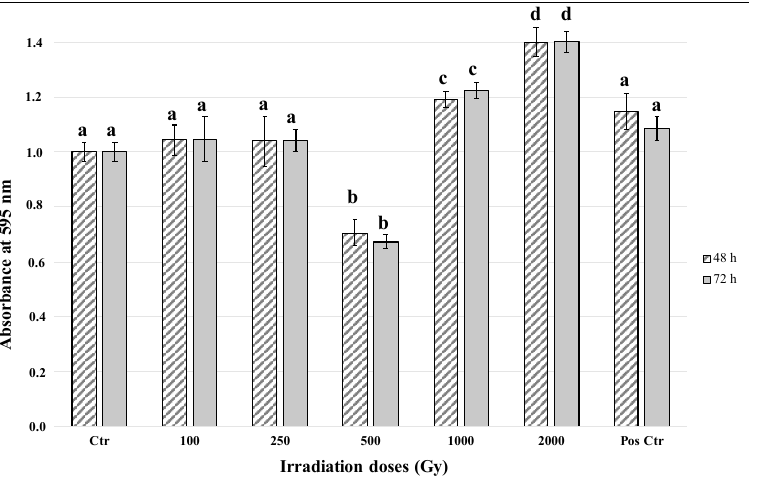
Figure 2. Metabolic activity of fungal cells after 48 h and 72 h rehydration. Striped bars indicate 48 h rehydration; grey bars indicate 72 h rehydration. Pos Ctr = DNA of C. antarcticus colony growth in physiological conditions. The same letters above bars indicate that the values are not statistically significant according to the t test ( p ≤ 0.05).